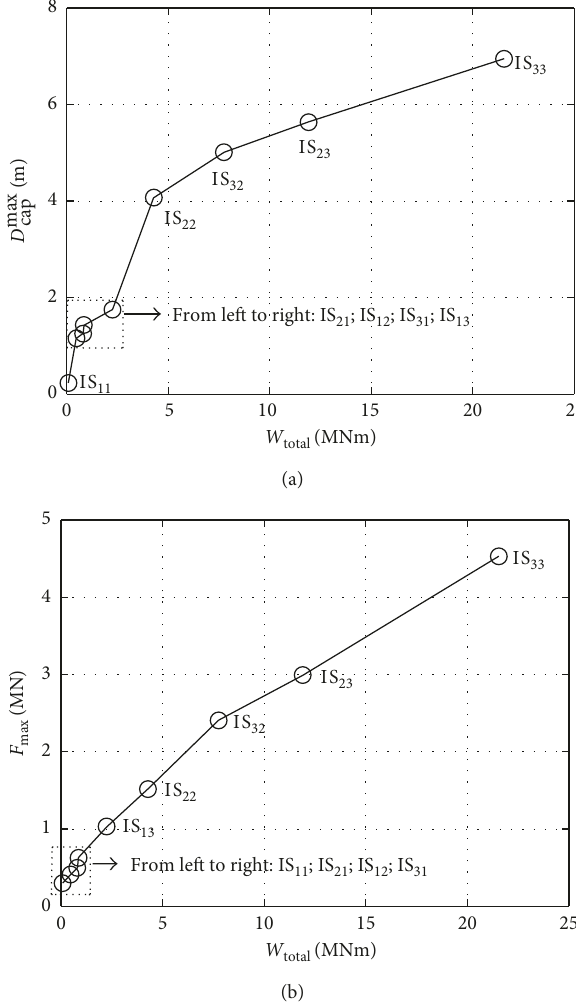
(a) and maximum cap